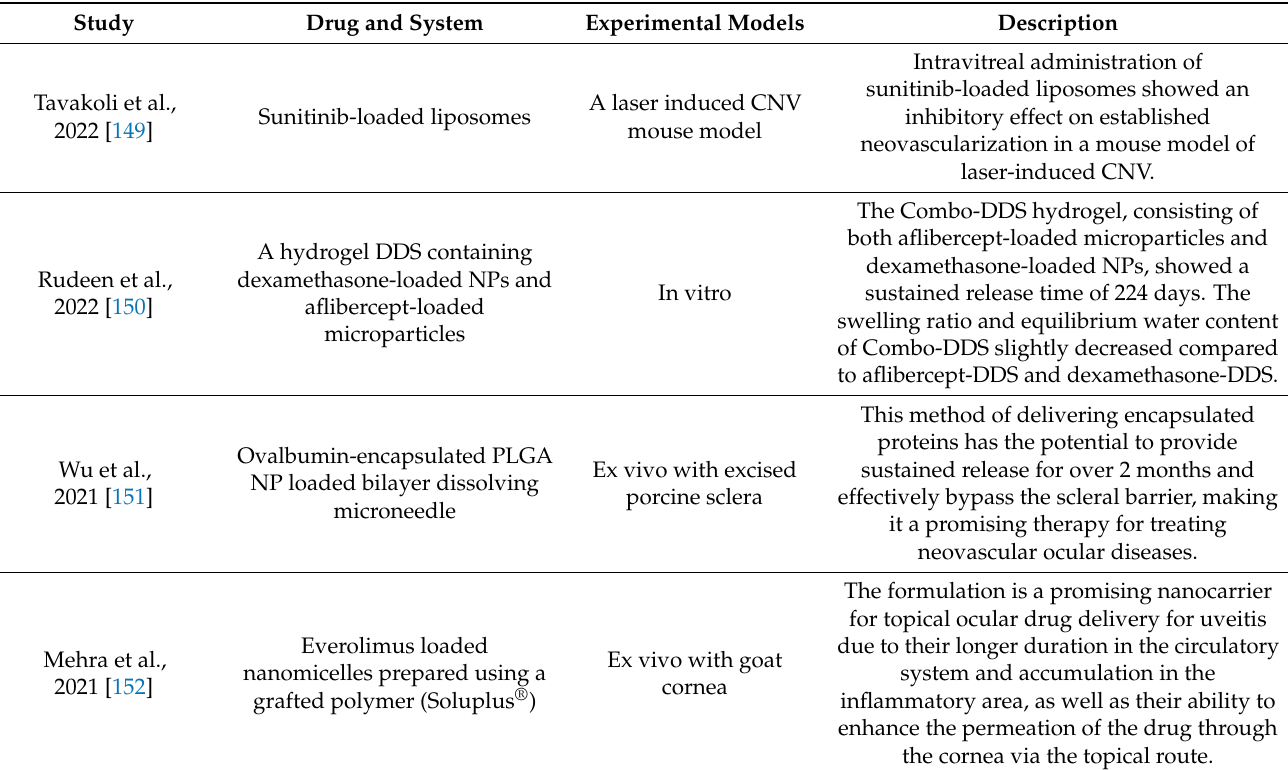
Table 3. Studies of biodegradable formulations for posterior segment